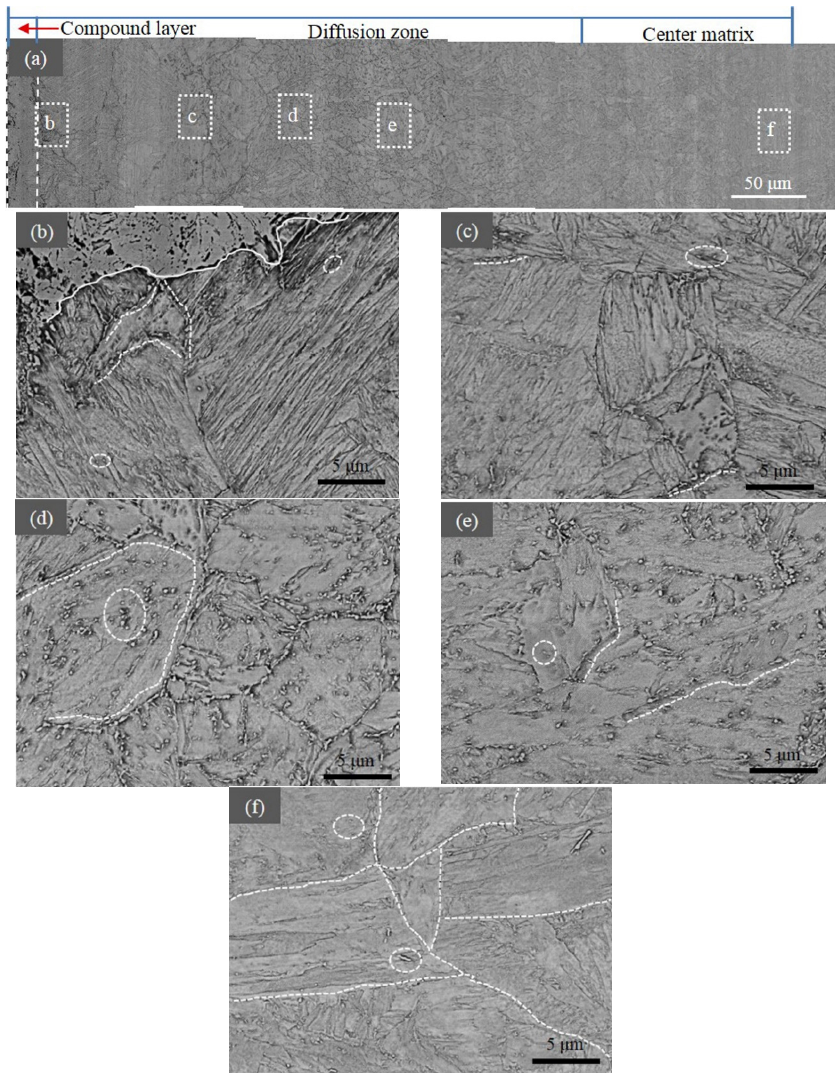
Figure 4. SEM-BSE images of the nitrided specimen at di ff erent depths. ( a ) Cross-sectional microstructure. Three zones according to the microstructure are marked, and the thin compound layer is indicated by two parallel white dashed lines. ( b ) The microstructure of the di ff usion zone at depth of 30–50 µ m. The up side is nearer to the surface. The interface between compound layer and di ff usion zone is marked by the white line, and some precipitates are marked by white dashed lines and circles. ( c ) The microstructure of di ff usion zone over the depth of 180–200 µ m. The presence of precipitate particles is marked using white dashed lines and circles. ( d ) The microstructure of a carbon-rich zone. The presence of precipitate particles is marked using white dashed lines and circles. ( e ) The microstructure of the di ff usion zone from 250 to 260 µ m. Precipitates are indicated by white dashed lines and circles. ( f ) The microstructure of the center matrix, whose boundaries are marked by white dashed lines and some precipitates, are marked by white dashed